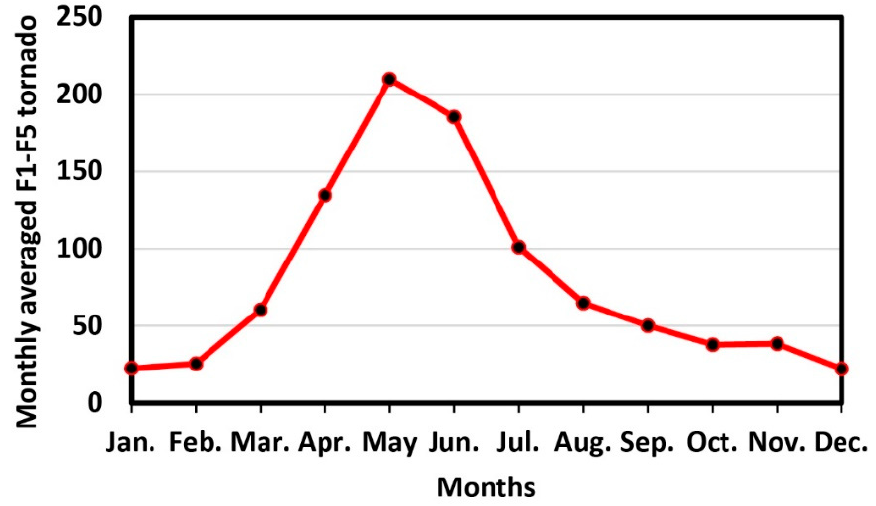
Figure 10. Monthly averaged (E)F1-(E)F5 tornado counts over the entire continental U.S. The statistical difference between the two means of high-event-year and low-event- year tornado numbers can be evaluated using a t test (see Equations (1) and (2)). The n 2 and n 1 ( n 2 = n 1 = 10) in Equation (1) are the sample size of 10 high-event and low-event years, and s in Equation (2) is the estimated standard deviation. Under the null hypothesis H o , Equation (1) obeys a t distribution with n 2 + n 1 − 2 (= 18) degree of freedom. The computed statistic t is 7.2 (> t 0.01 = 2.9), indicating that the difference of two means is statistically significant at a level of